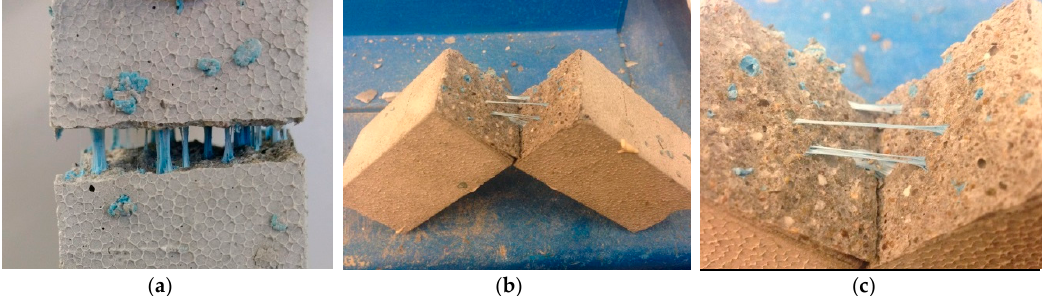
Figure 10. Typical images showing the crack bridging function of mortar with ( a ) 4% and ( b , c ) 1% of WSRPs as a replacement of